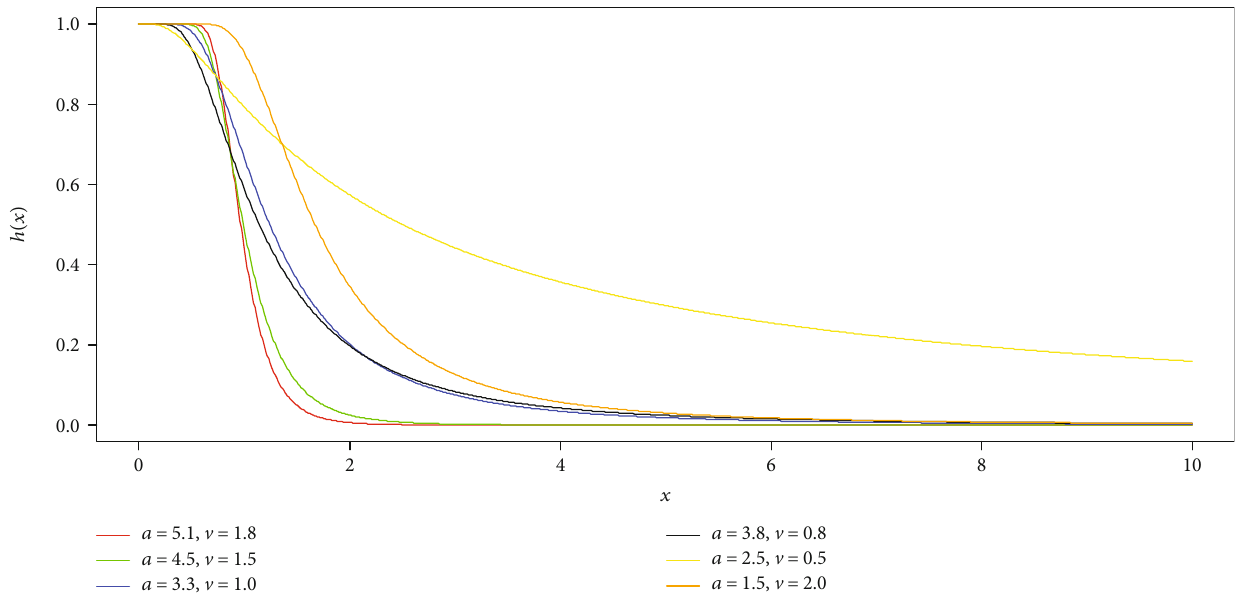
Figure 3: The graph of the reliability function of EGTT distribution.